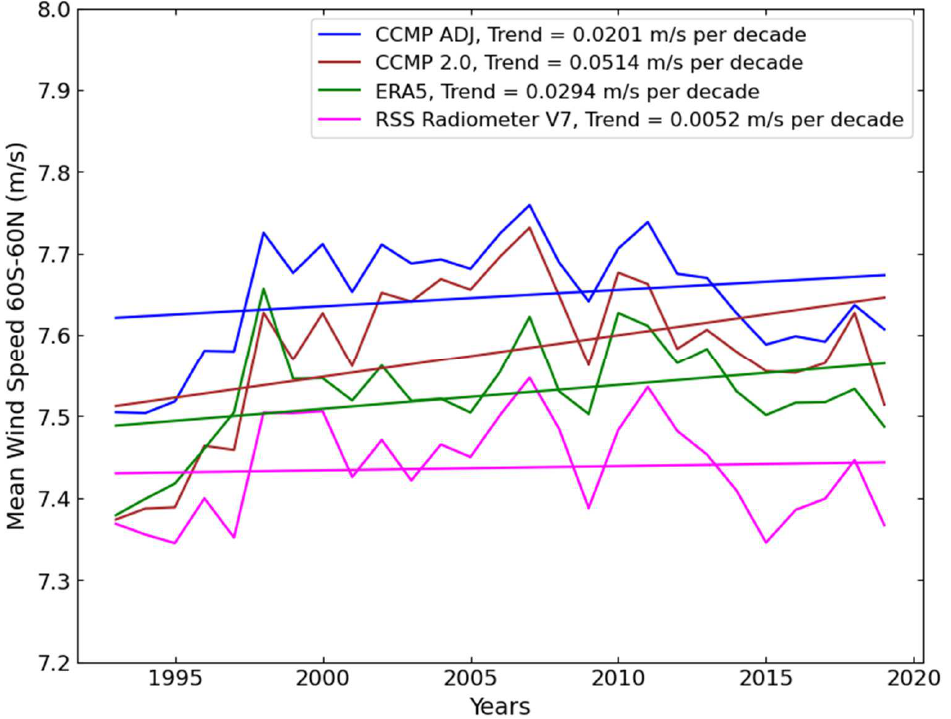
Figure 16. Time series of annual, globally averaged (60S–60N) mean wind speed for two versions of CCMP, ERA5_OSCAR, and merged RSS radiometer winds.